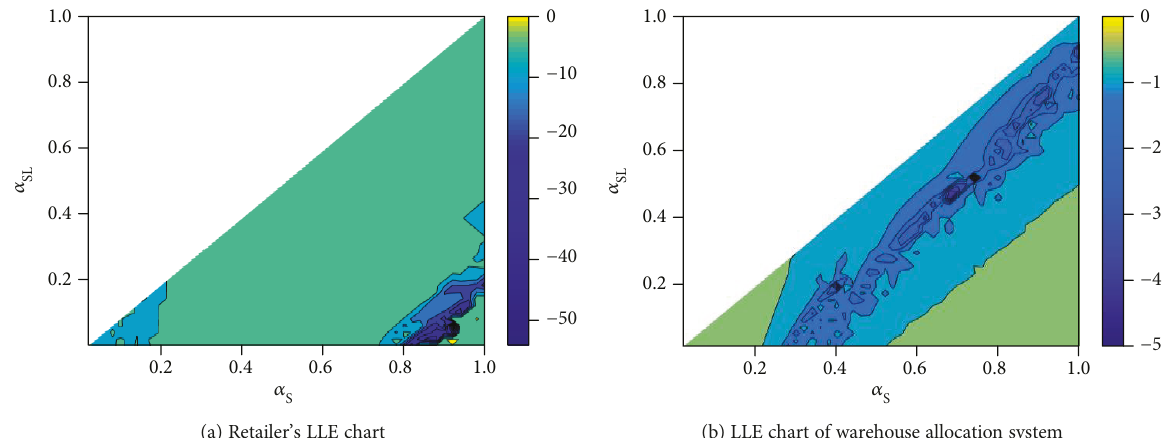
Figure 4: LLE diagram of members following fi xed constant